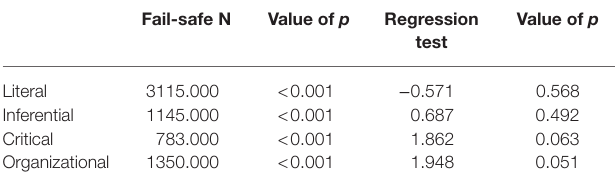
TABLE 4 | Publication bias results.